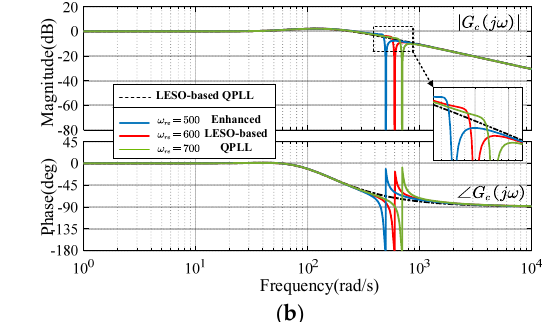
Figure 8. Bode diagram: ( a ) Bode diagram of G o ( s ) under different ω re . ( b ) Bode diagram of G c ( s ) under different ω c